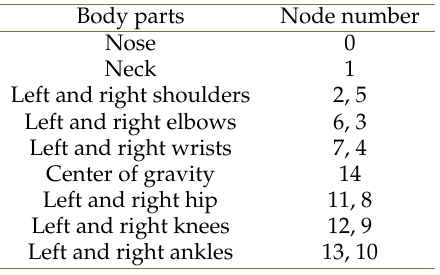
Table 1. Correspondence table for number and body part.